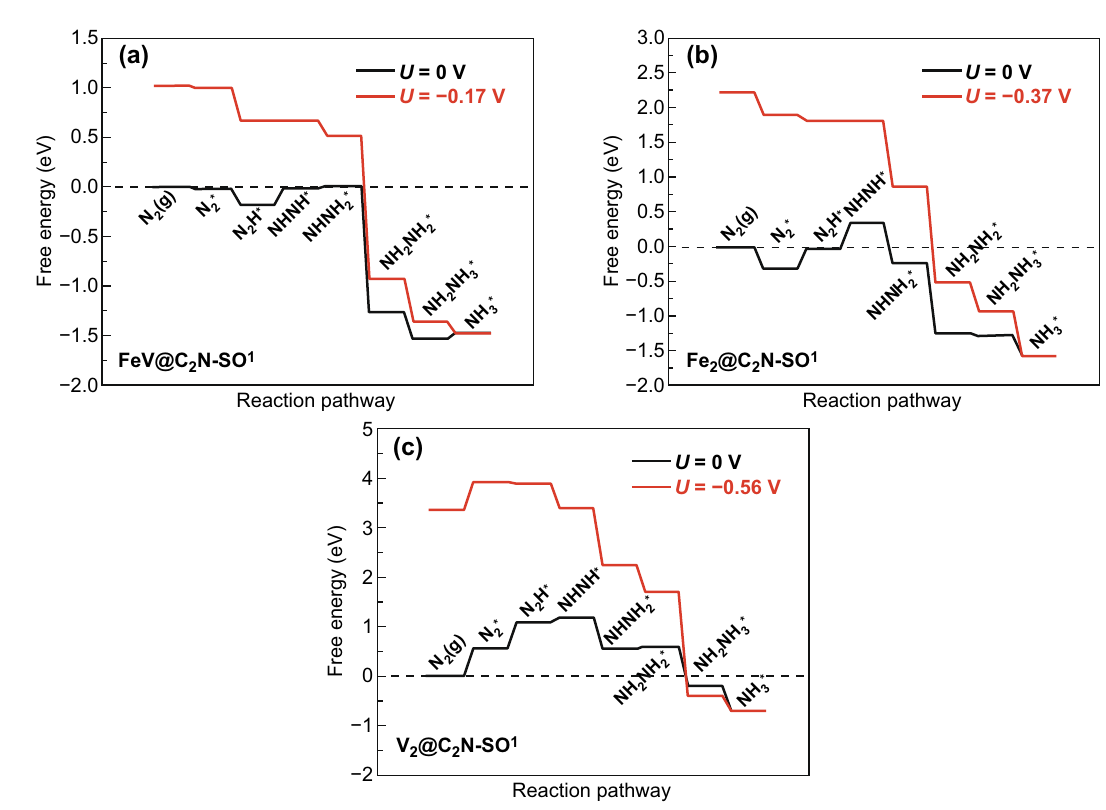
Fig. 2 a – c Free energy diagrams of the three electrocatalysts [15]. Copyright 2020